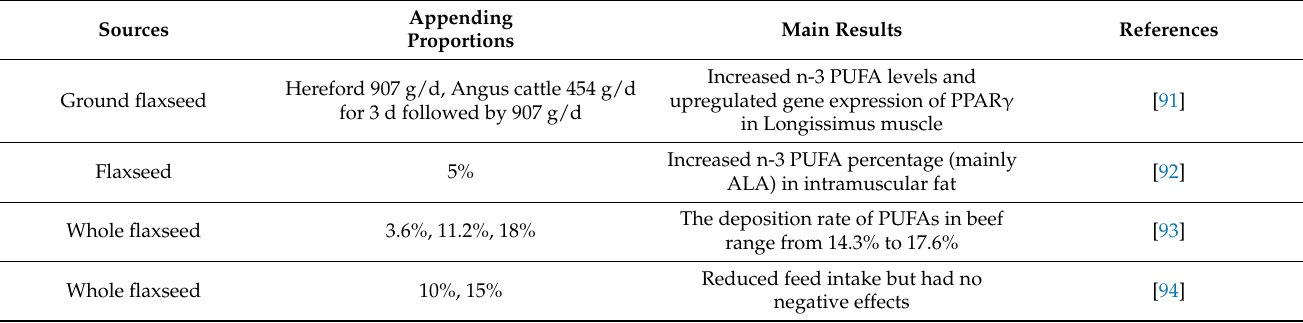
Table 8. Application of flaxseed and flaxseed meal in beef